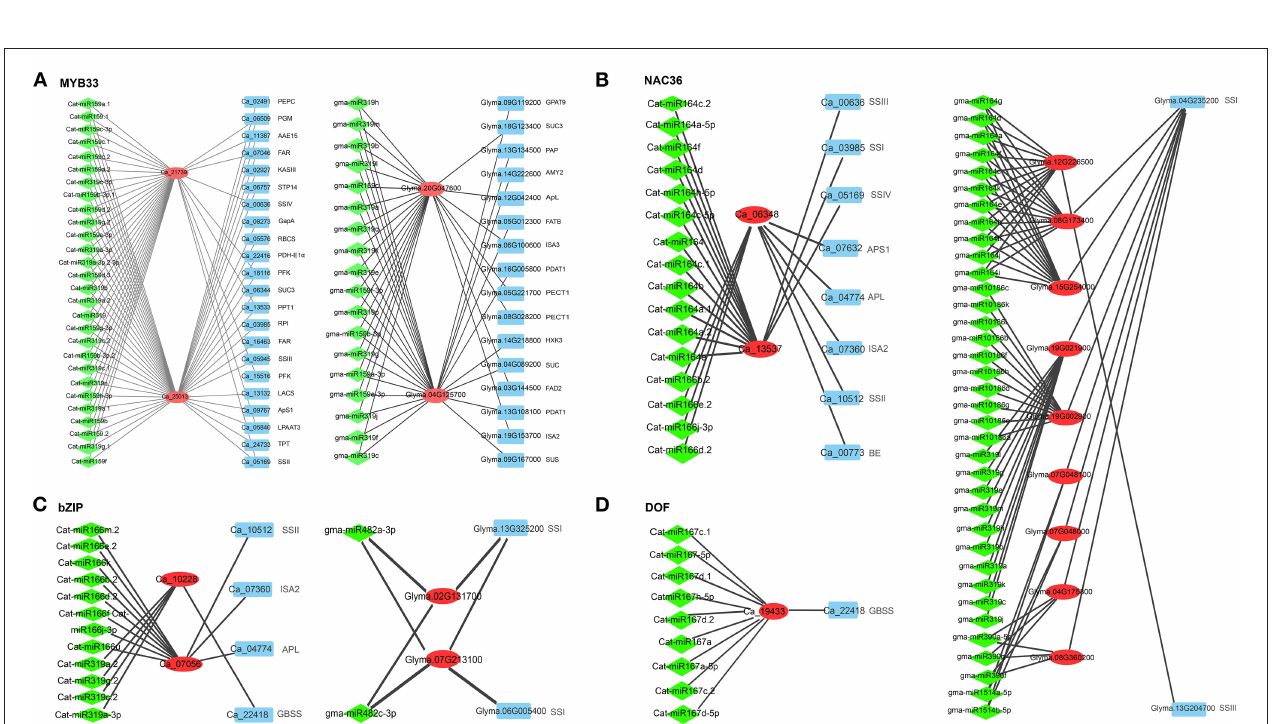
FIGURE 3 | The relative expression levels of four starch synthesis genes APL2 (A) , GBSS (B) , SSIII (C) , and APS1 (D) , which are common genes in soybean and chickpea, at five seed development stages.